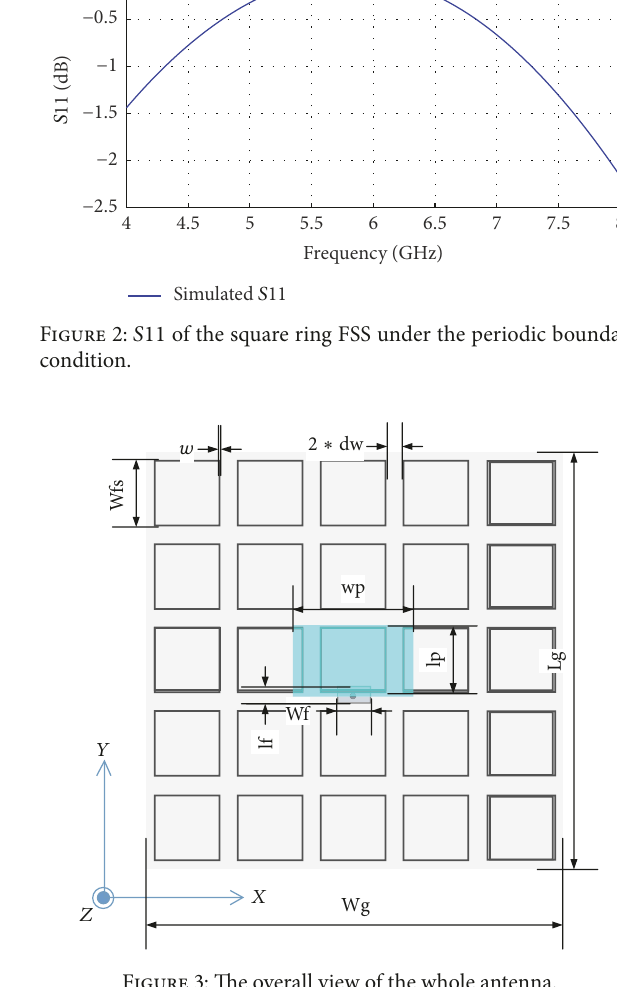
Figure 3: The overall view of the whole